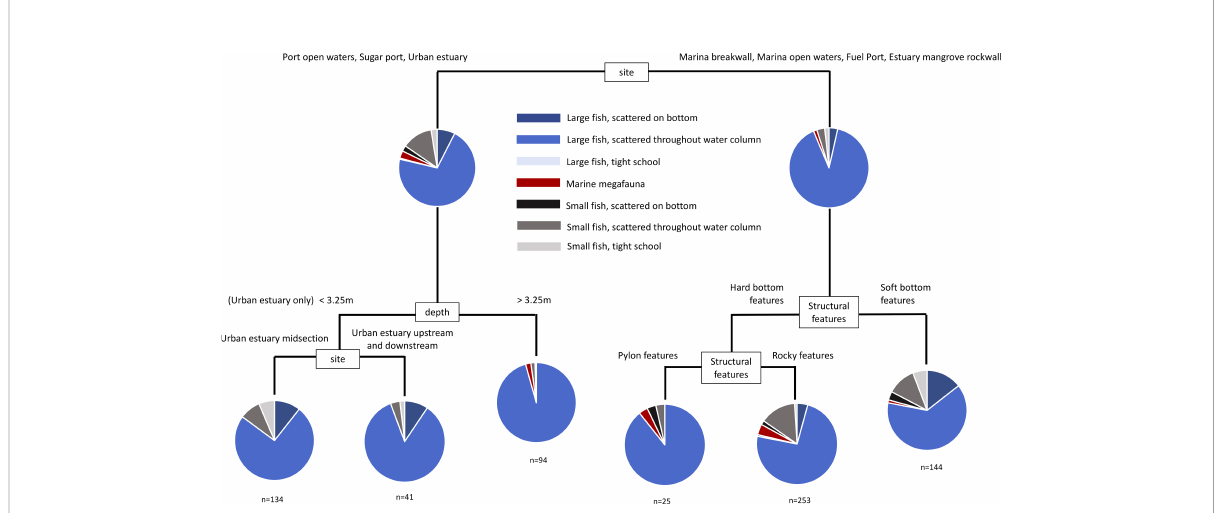
FIGURE 7 Multivariate classi fi cation and regression tree of the assemblage of mobile marine fauna from night time sonar sampling. Sites were replicated at each sampling event (see Table S4).